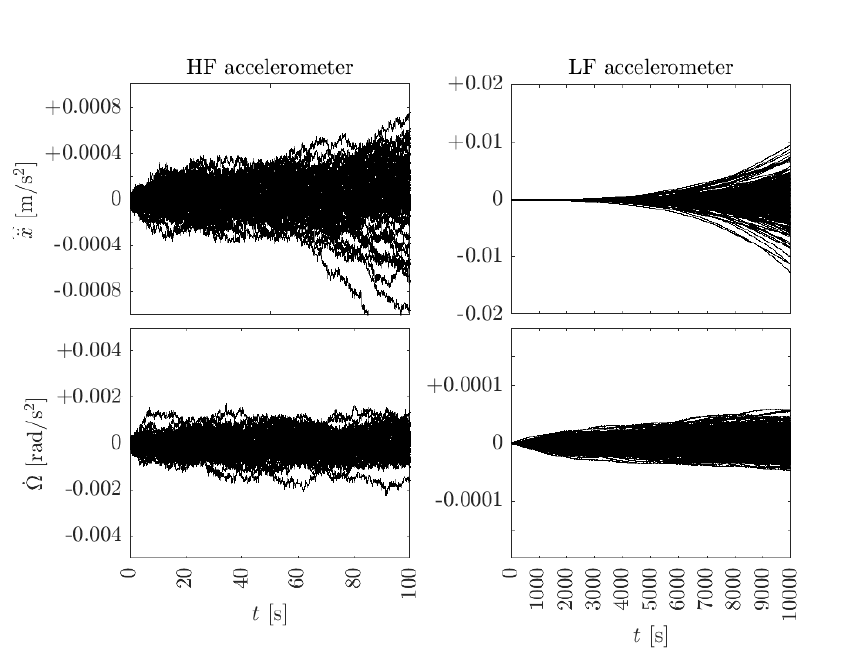
Figure 5. Time − domain simulation results for linear ( top ) and angular ( bottom ) accelerations. Left: high-frequency accelerometer. Right: low-frequency accelerometer, where the effect of angular velocity leakage into linear acceleration is clearly visible after 2000 s. A total of 1000 independent simulations are shown where no force or torque was applied to the body.